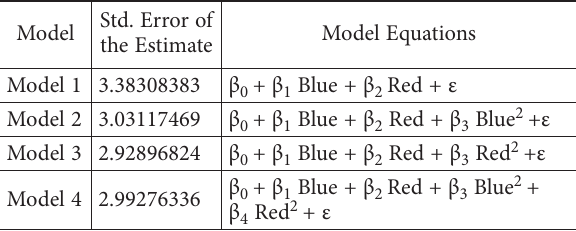
Table 6. The combinations of blue and red channels Std. Error of Model the Estimate